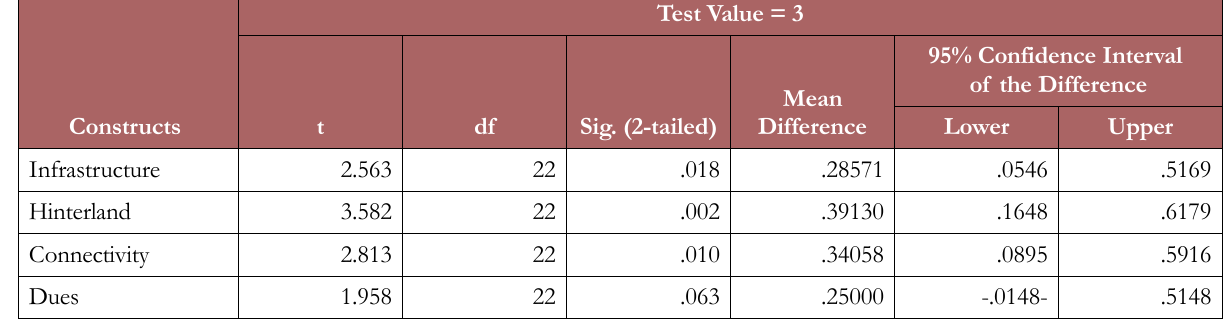
Table 8. One-Sample Test